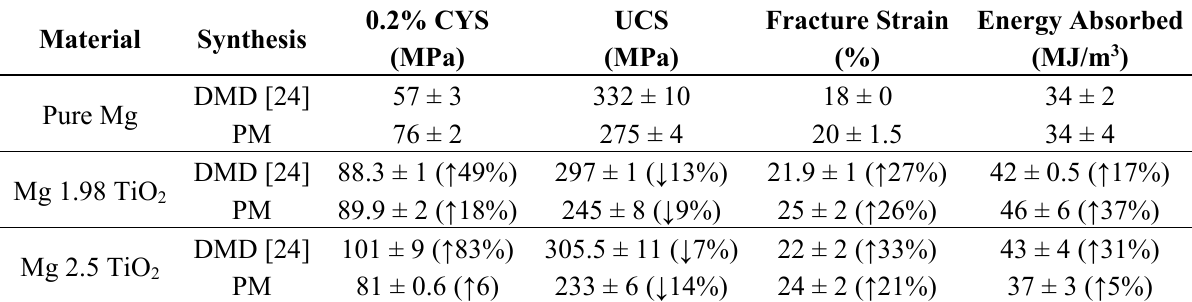
Table 6. Results of room temperature compression